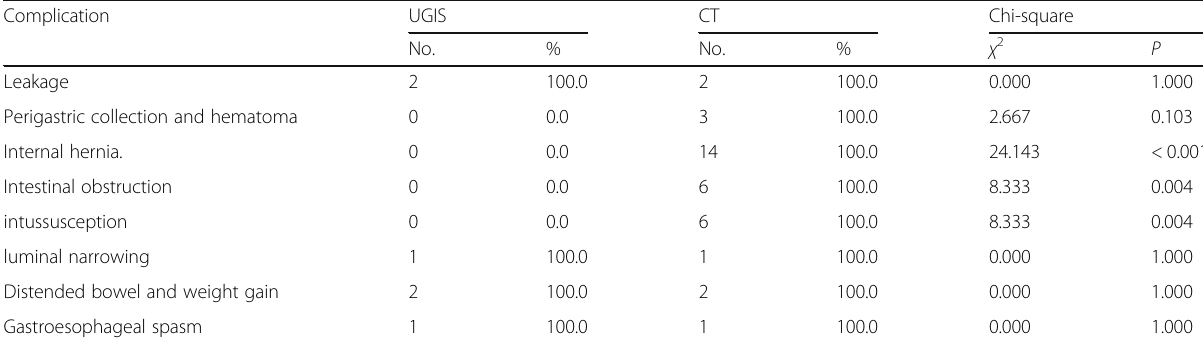
Table 4 Comparison of UGIS and CT in the detection of Roux-en-Y gastric bypass postoperative complications ( N = 35)